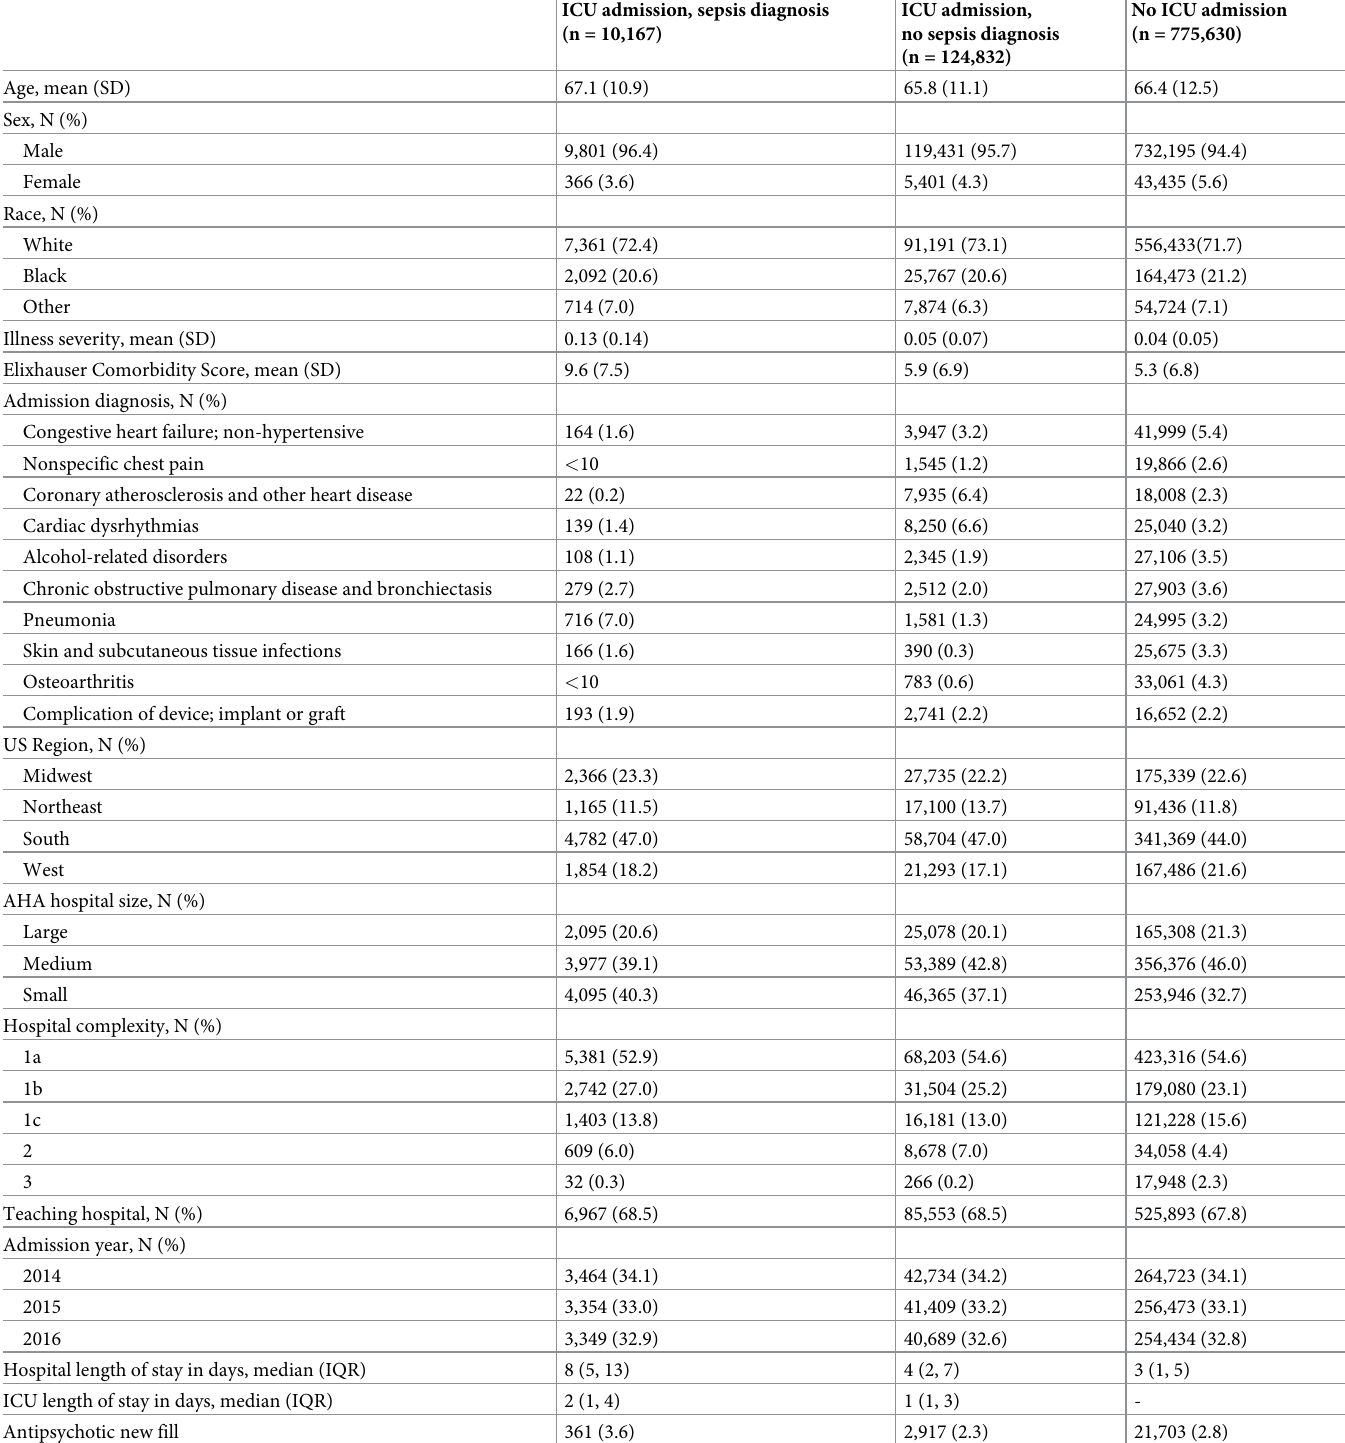
Table 3. Patient and hospital level characteristics of the antipsychotic cohort by hospitalization